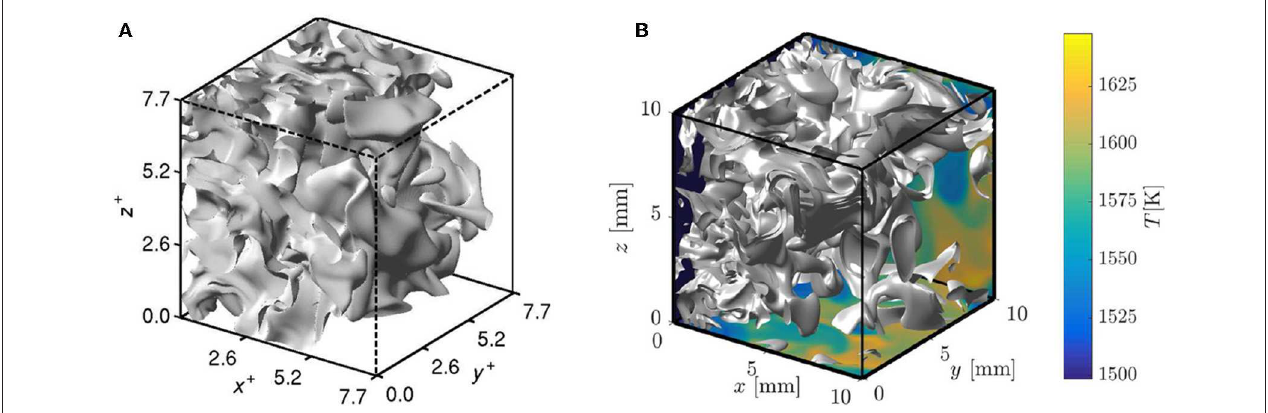
FIGURE 4 | Iso-surface of normalized heat release rate of 2 from (A) P3 and (B) NP1 MILD combustion cases. The temperature field is shown in the bottom and side surfaces in (B) . The axes are normalized using the laminar flame thermal thickness for the premixed case P3. These figures are adapted from Minamoto (2013) for P3